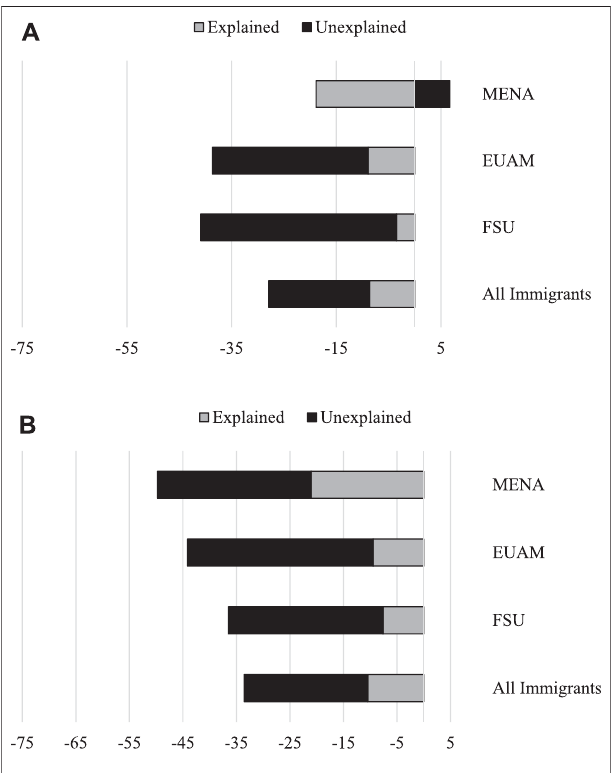
FIGURE 1 | (A) Decomposition of the total gap in the severity illness index (measured on a 100-point percentile scale) by nativity status, Men. (B) : Decomposition of the total gap in the severity illness index (measured on a 100-point percentile scale) by nativity status, Women.